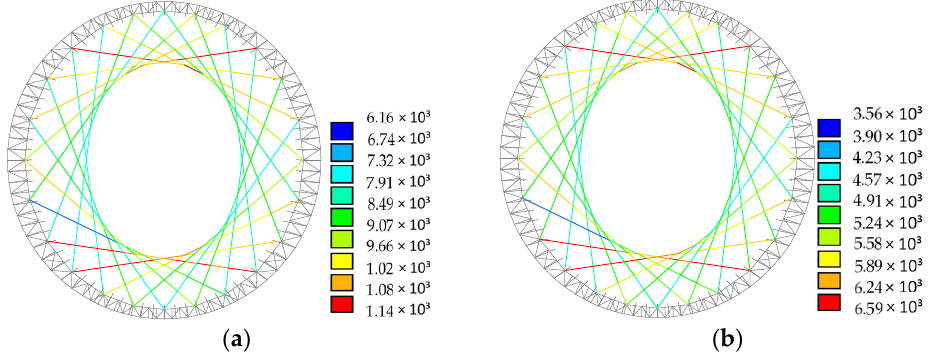
Figure 5. Contours of envelope cable tensions: ( a ) maximum cable tensions/kN and ( b ) minimum cable tensions/kN.